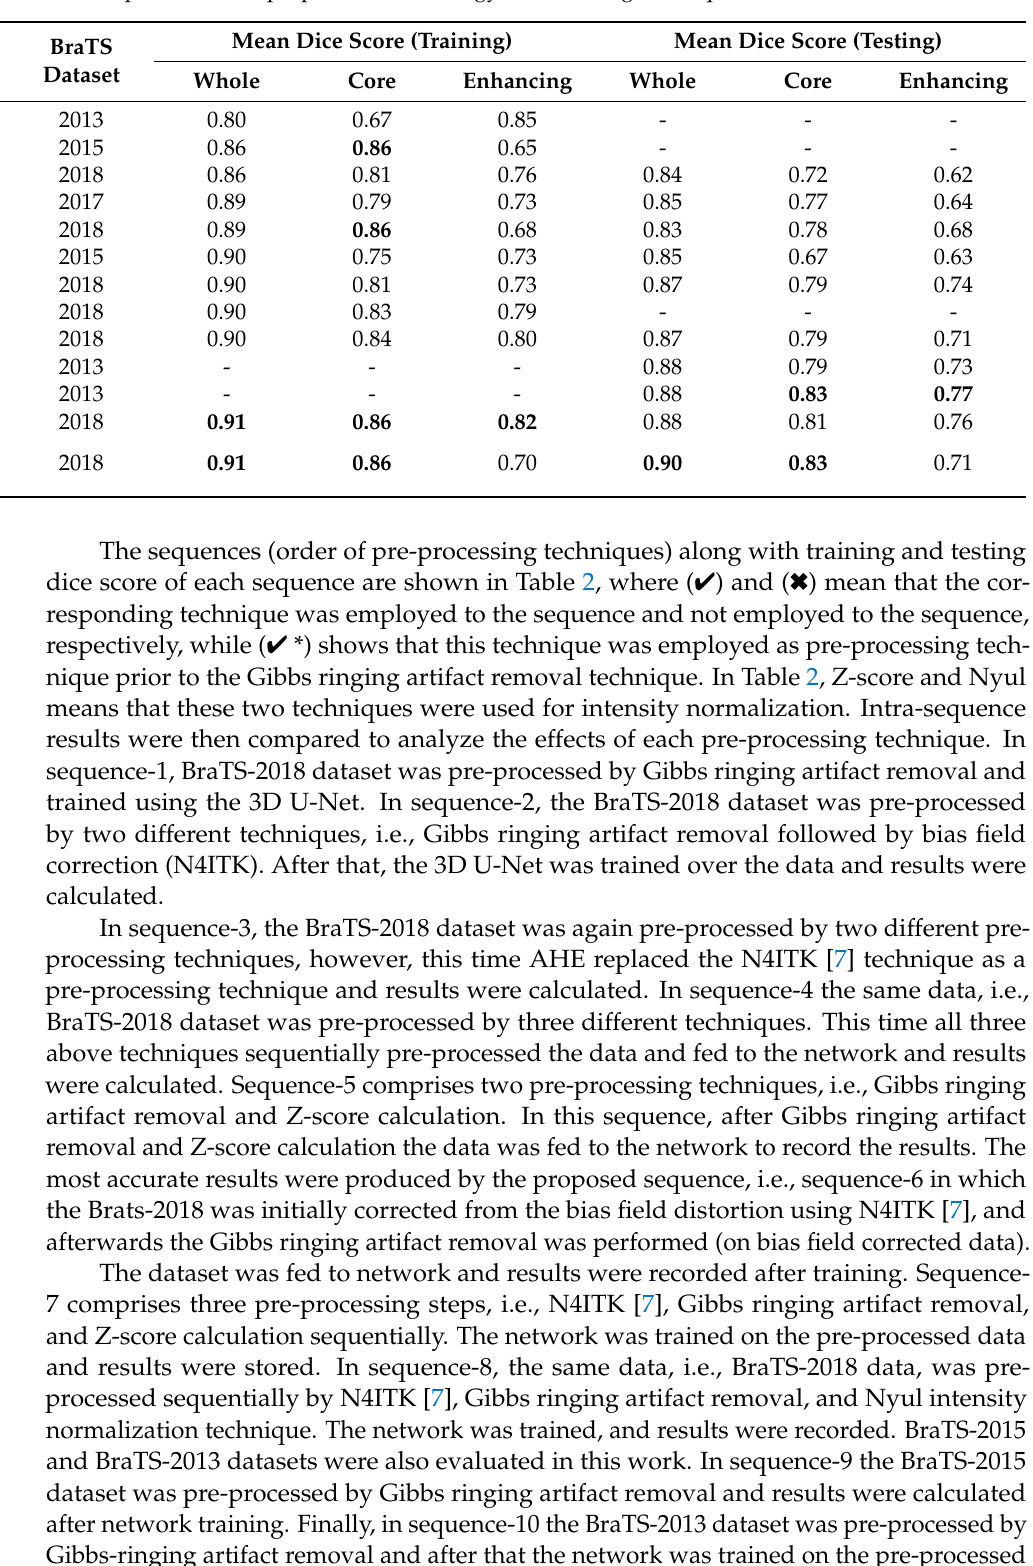
Table 3. Comparison of the proposed methodology with existing